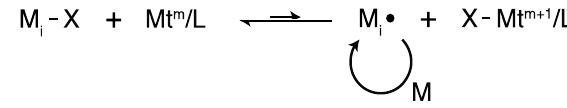
Figure 8. Atom transfer radical polymerization mechanism [70]. M = vinyl monomer, M i = polymer with i repeat units, X = halide, Mt = transition metal with oxidation state m , and L = ligand. Arrows show reaction direction.